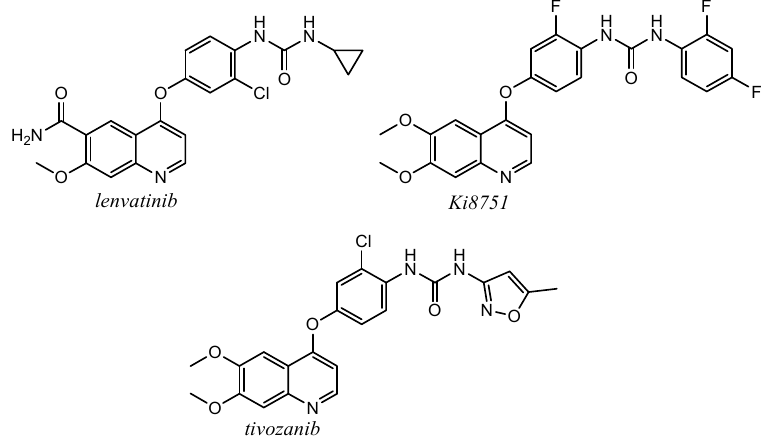
Figure 28. Structures of VEGFR inhibitors with quinoline-urea moiety lenvatinib , Ki8751 , tivozanib